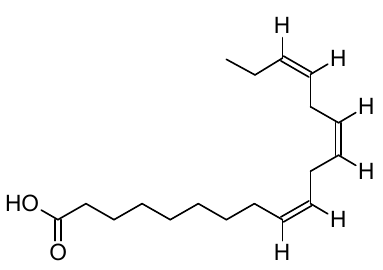
Figure 6. Chemical structure of α -linolenic acid.